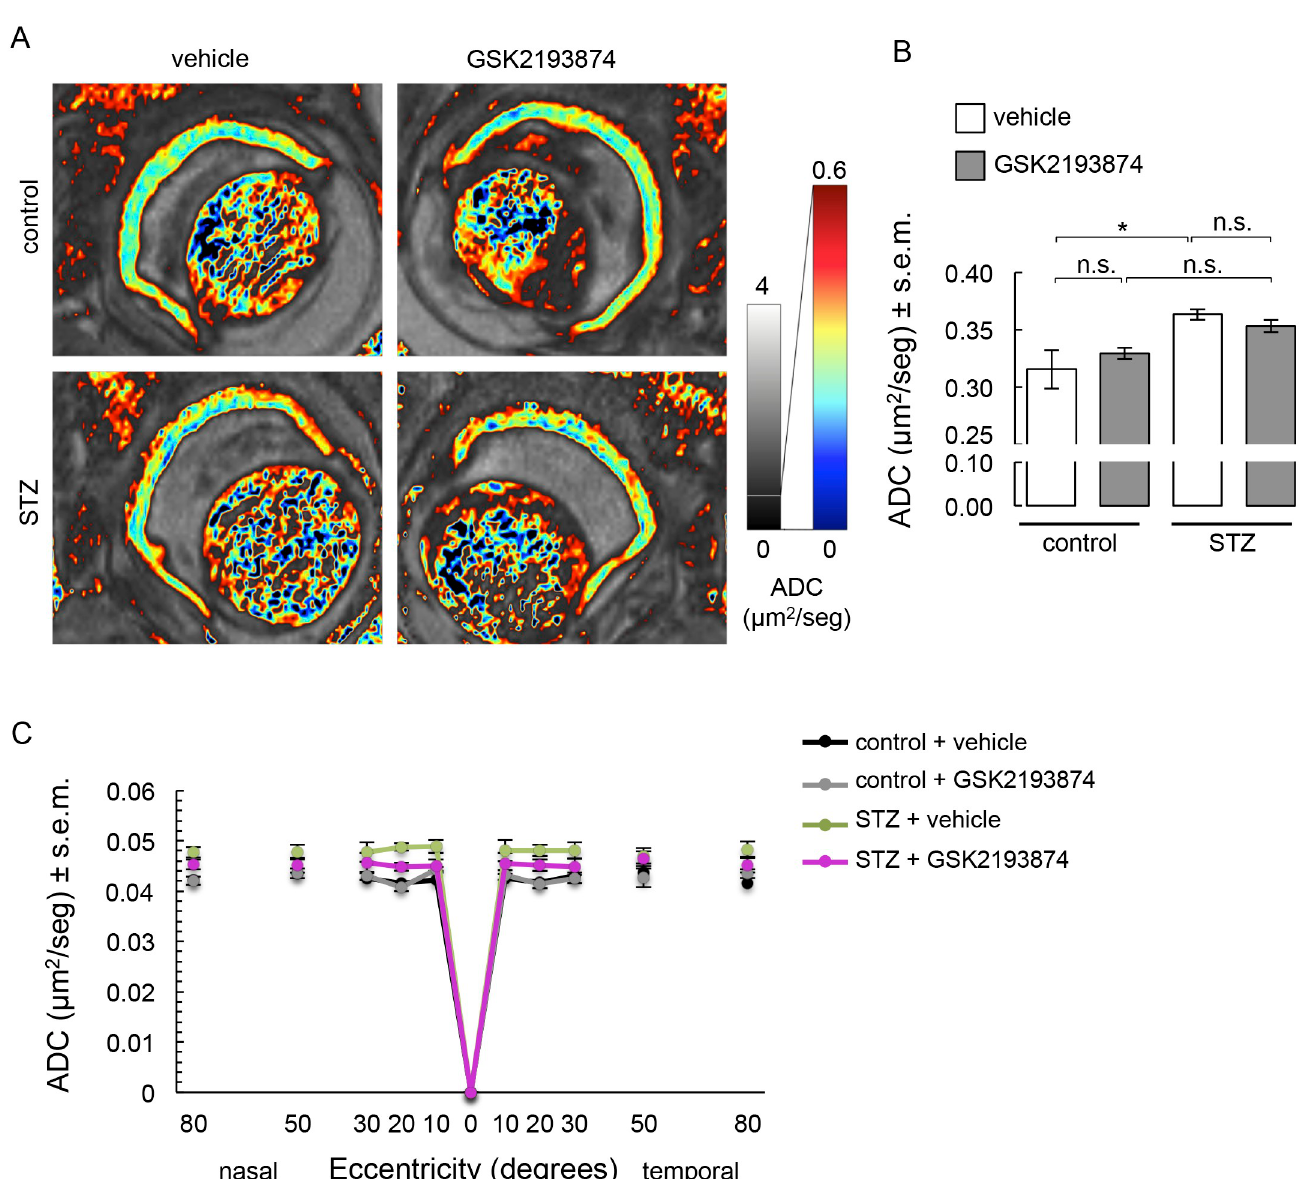
Fig 4. Water diffusion in control and STZ mice that received a single intravitreal injection of TRPV4 antagonist GSK2193874 on the left eye and vehicle (PBS) on the right eye, 24 hours before the end of the 4-week STZ treatment. ( A ) Representative images of ADC maps. ( B ) Summary of ADC and ( C ) corresponding retinal segment analysis in four separate groups. Error bars correspond to s.e.m. � , significant difference (P < 0.05); n.s., not significant. In C, vehicle-treated STZ retinas had a significantly higher ADC than that of vehicle-treated control retinas. The ADC of GSK2193874-treated STZ retinas was not different from that of vehicle-treated retinas and GSK2193874-treated control retinas.